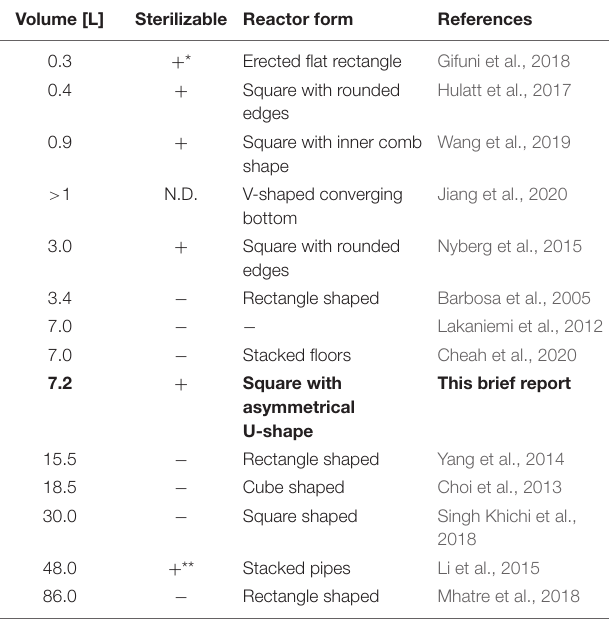
TABLE 1 | Comparison of the photobioreactor presented in this brief report with selected flat panel photobioreactors in the laboratory scale as described in literature regarding their volume and